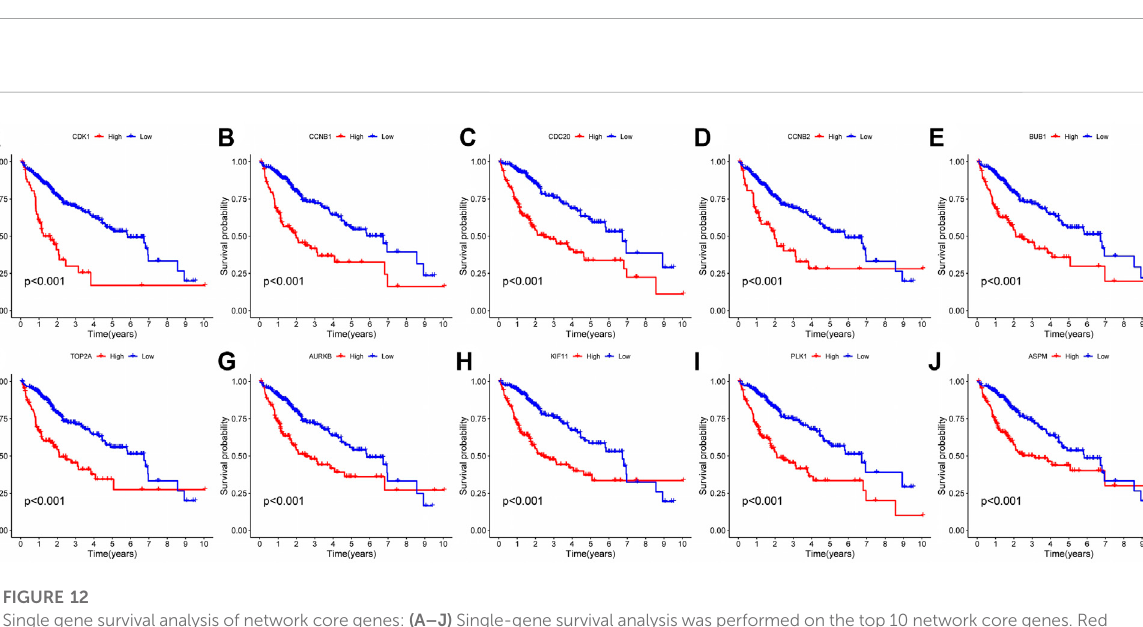
FIGURE 11 Searching network coregenes by PPI analysis (A) PPI analysis of differentially expressedgenes between different risk groups was performed on STRINGonlinewebsite(highcon fi dence=0.9); (B) ThePPIanalysisresultswereimportedintoCytoscapesoftwaretosearchfornetworkcoregenes, which were marked in